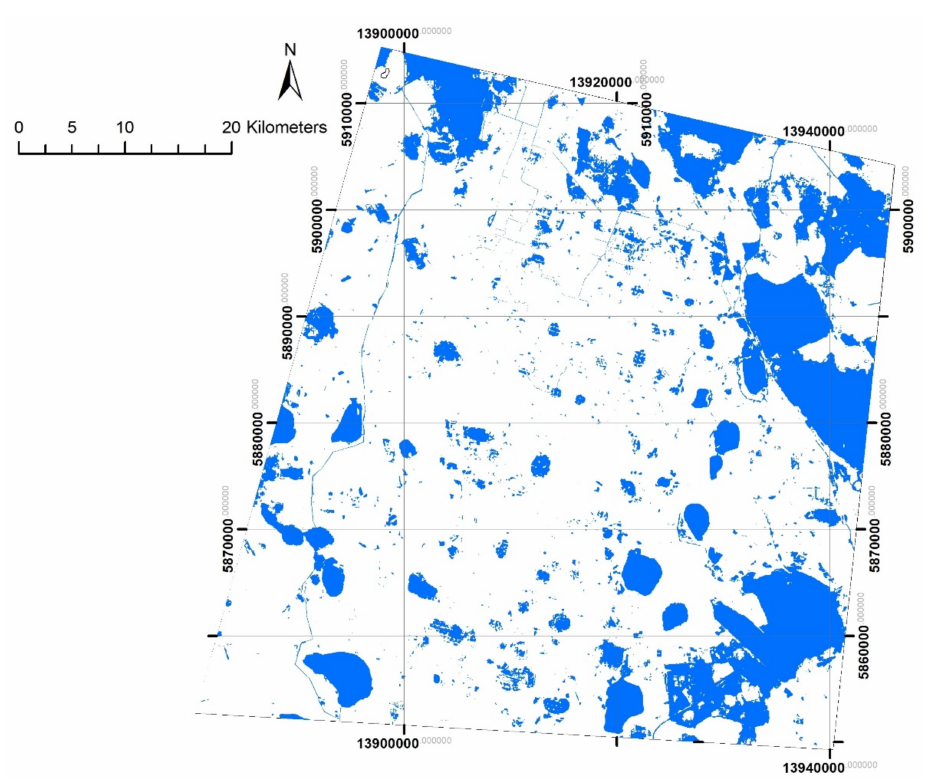
Figure 7. The water network of Daqing. A combination of the data on the area from Sentinel-2 and of visual mapping. Map by S. J. Hauser with the software